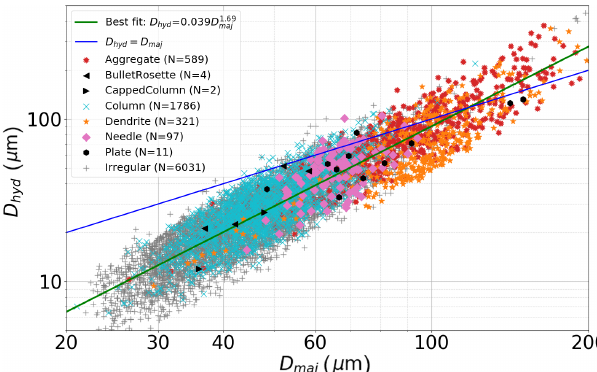
Figure 7. Relation between the hydrodynamic diameter D hyd cal- culated using Eq. (7) and the measured particle size D maj of falling crystals. Different crystal habits (classified by the trained predictor) are marked as different symbols and colors. Power law fit as green line, D hyd = 0 . 039 D 1 . 69 , with both D hyd and D maj (in µm). The maj blue line represents D hyd = D maj .